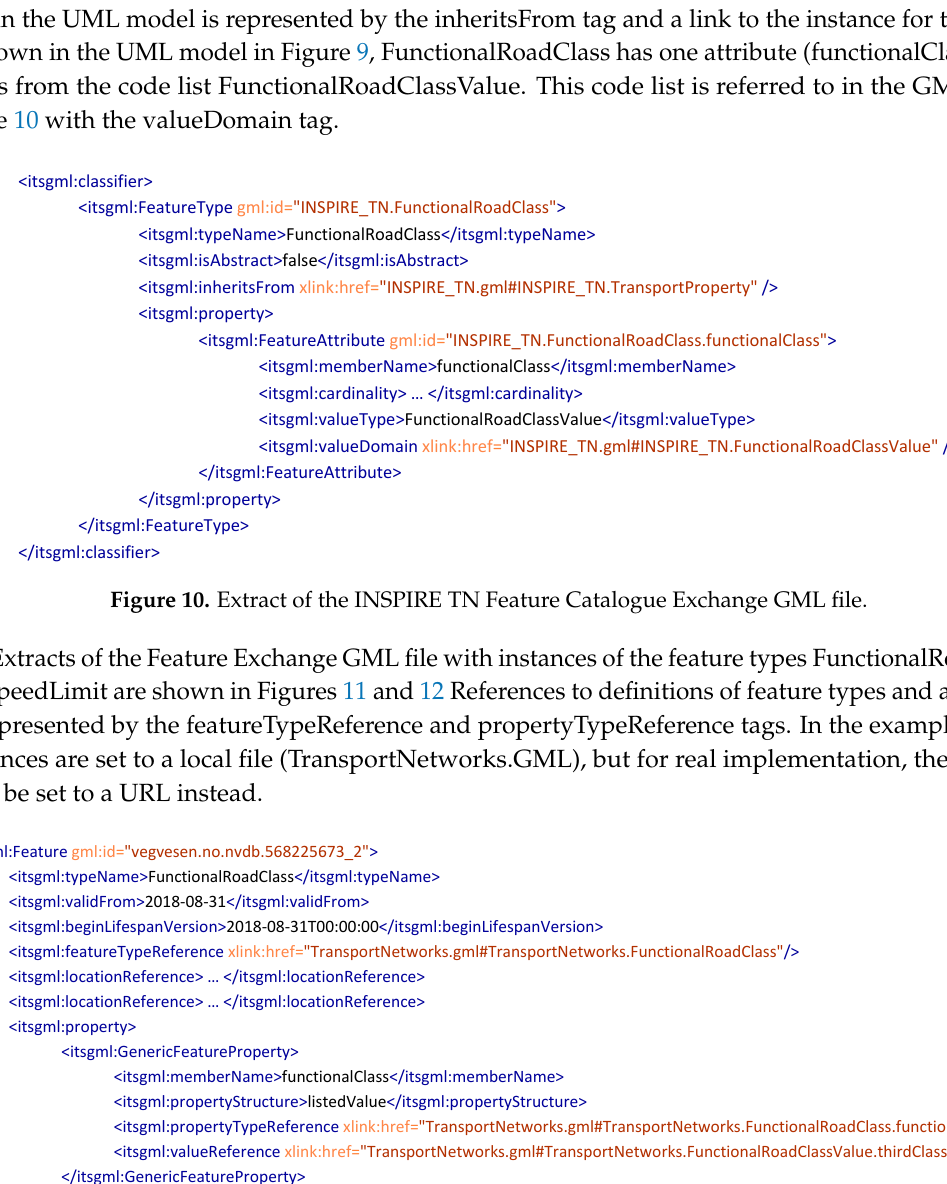
Figure 11. Extract of the INSPIRE TN Feature Exchange GML file with an instance of the FunctionalRoadClass feature type.